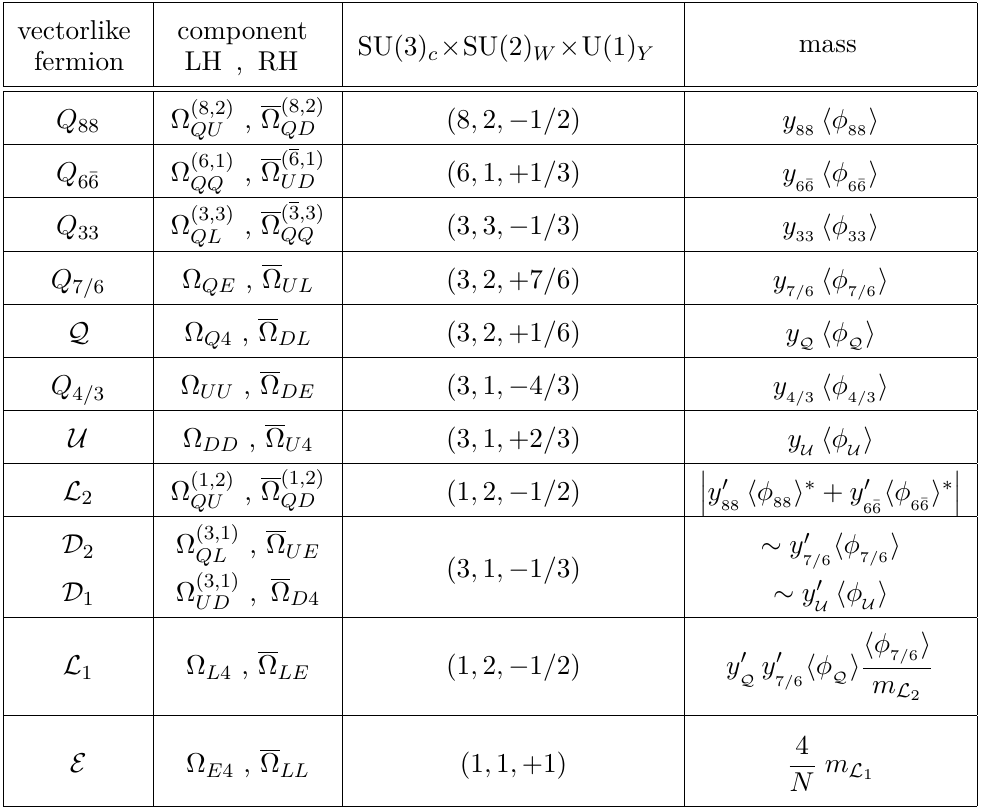
Table 2 . Composite vectorlike quarks and leptons, and their representations under the SM gauge group. Left-handed components of the vectorlike fermions are prebaryons, while right-handed components are conjugates of other prebaryons. For example, the vectorlike quark U has a left- handed component given by the ψ ψ Ω ≡ Ω DD prebaryon, while its right-handed component is the D D conjugate of the ψ ψ Ω ≡ Ω U 4 prebaryon. The table rows are ordered according to the fermion 4 U masses, with the heaviest one at the top, but some of the Vquarks are roughly degenerate.